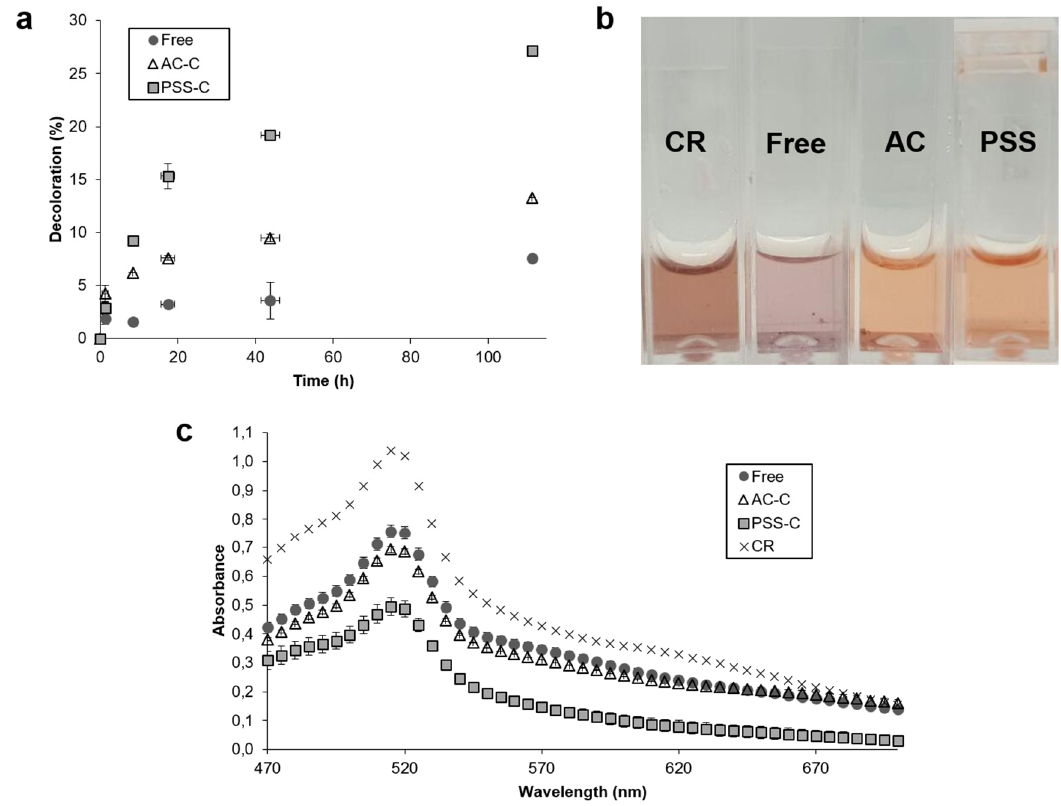
Figure 6. Decolorization measurements of free laccase, AC-C, and PSS-C in 3 mL cuvettes. ( a ) Percentage of decolorization as a function of time, and ( b ) solutions after decolorization assays ( c ) final spectrophotometric measurement of Congo Red (CR), free laccase, AC-C, and PSS-C. Upon encapsulation, the decolorization activity of laccase molecules significantly increased and approach about 25% for those encapsulated in PSS and about 10% for AC microcapsules. This was corroborated by colorimetric and spectrophotometric measurements.